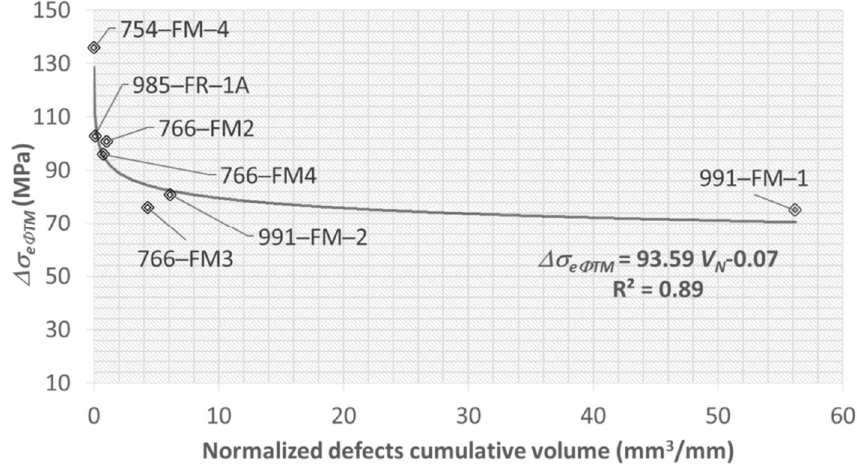
Figure 21. Fatigue strength (Δσ eΦTM ) vs. normalized defects cumulative volume (V N ) [128].